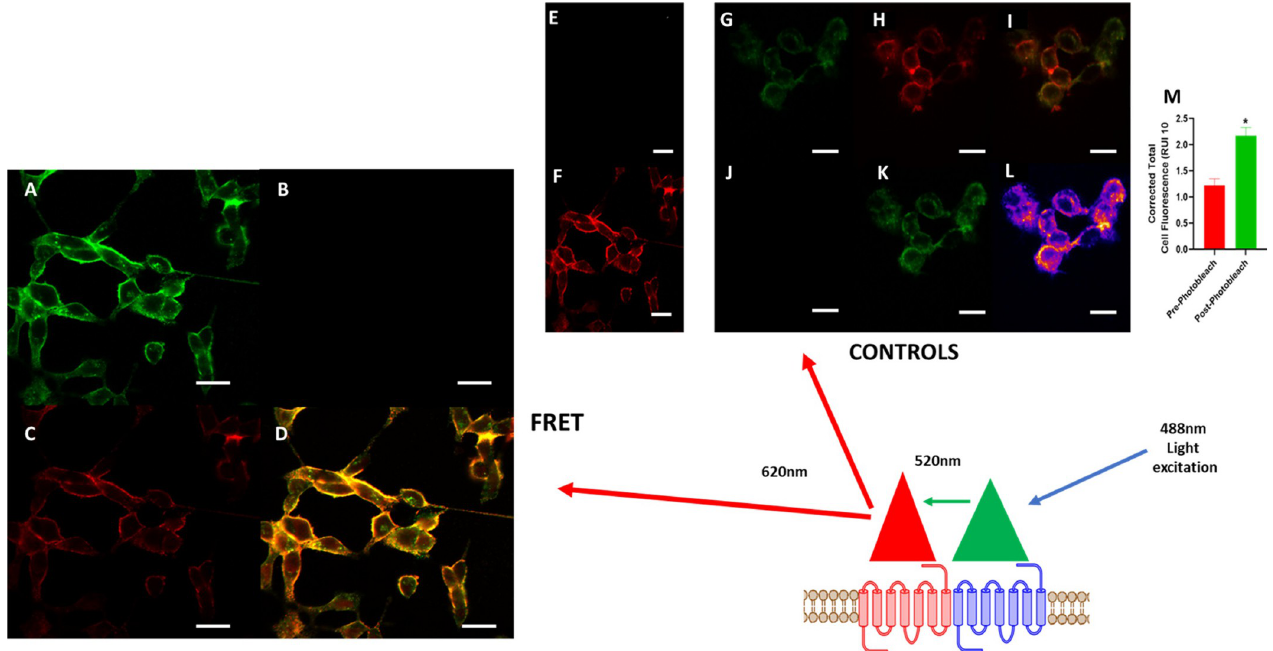
Fig 7. FRET was used to demonstrate proximity of the fluorescent ligands. (A) 100nM Derm ATTO488 bound to HEK MOP/NOP cells is activated by 488nm laser and can be measured in the green channel; no fluorescence is demonstrated in the red channel (B). Following the addition of N/OFQ ATTO594 , fluorescence is now detected by FRET in the red channel following stimulation with the 488nm laser (C). There is significant overlap with the green channel (D), shows merged image (Derm ATTO 488 excited by 488nm wavelength, N/OFQ ATTO594 by 594nm wavelength) demonstrating colocalisation (Pearson Correlation Coefficient = 0.89) further indicating a close proximity between Derm ATTO488 and N/OFQ ATTO594 . In order to demonstrate FRET-pairing of Derm ATTO488 and N/OFQ ATTO594 , a series of control experiments were performed. N/OFQ ATTO594 (100nM) was incubated with HEK MOP/NOP cells and stimulated by 488nm laser (E) and the 594nm laser (F). No fluorescence emission was demonstrated by stimulation with the 488nm laser, while N/OFQ ATTO594 was activated by the 594nm laser. A further confirmation of FRET pairing is through photobleaching of the acceptor molecule. HEK MOP/NOP cells were co-incubated with 100nM Derm ATTO488 (G) and N/OFQ ATTO594 (H) with co-localisation demonstrated in (I). N/OFQ ATTO594 was exposed to 594nm until loss of fluorescence (i.e photobleaching) was seen (J). At this point, Derm ATTO488 fluorescence was measured (K) following which a heatmap (L) was generated, which demonstrated several areas of increased fluorescence (orange). The graph (M) demonstrates levels of fluorescence produced by Derm ATTO488 in HEK MOP/NOP pre and post photobleaching (p < 0.05; student’s t-test). Data are the mean ± SEM of five experiment. Scale bar (white) represents 20 μ m.